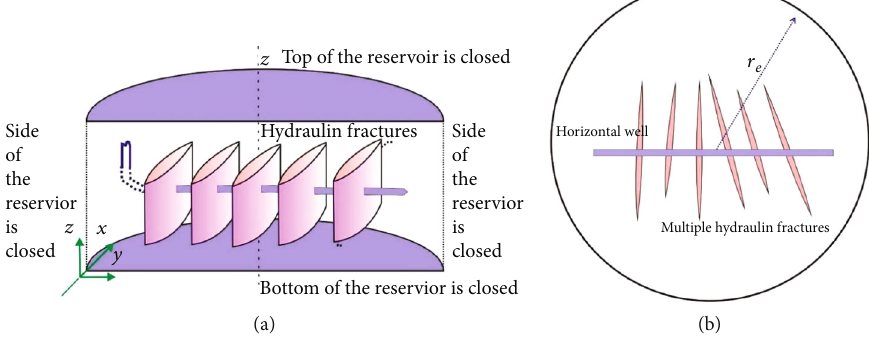
Figure 1: Schematic of the multistage fractured horizontal well with unevenly distributed variable conductivity fractures: (a) 3D distribution schematic of multiple variable conductivity fractures; (b) 2D uneven distribution schematic of multiple variable conductivity